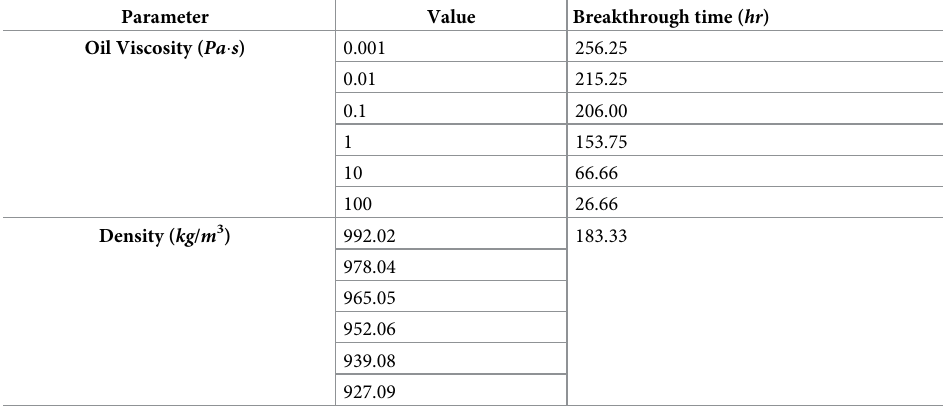
Table 7. Calculated breakthrough times for the oil viscosity and density sensitivity analysis.